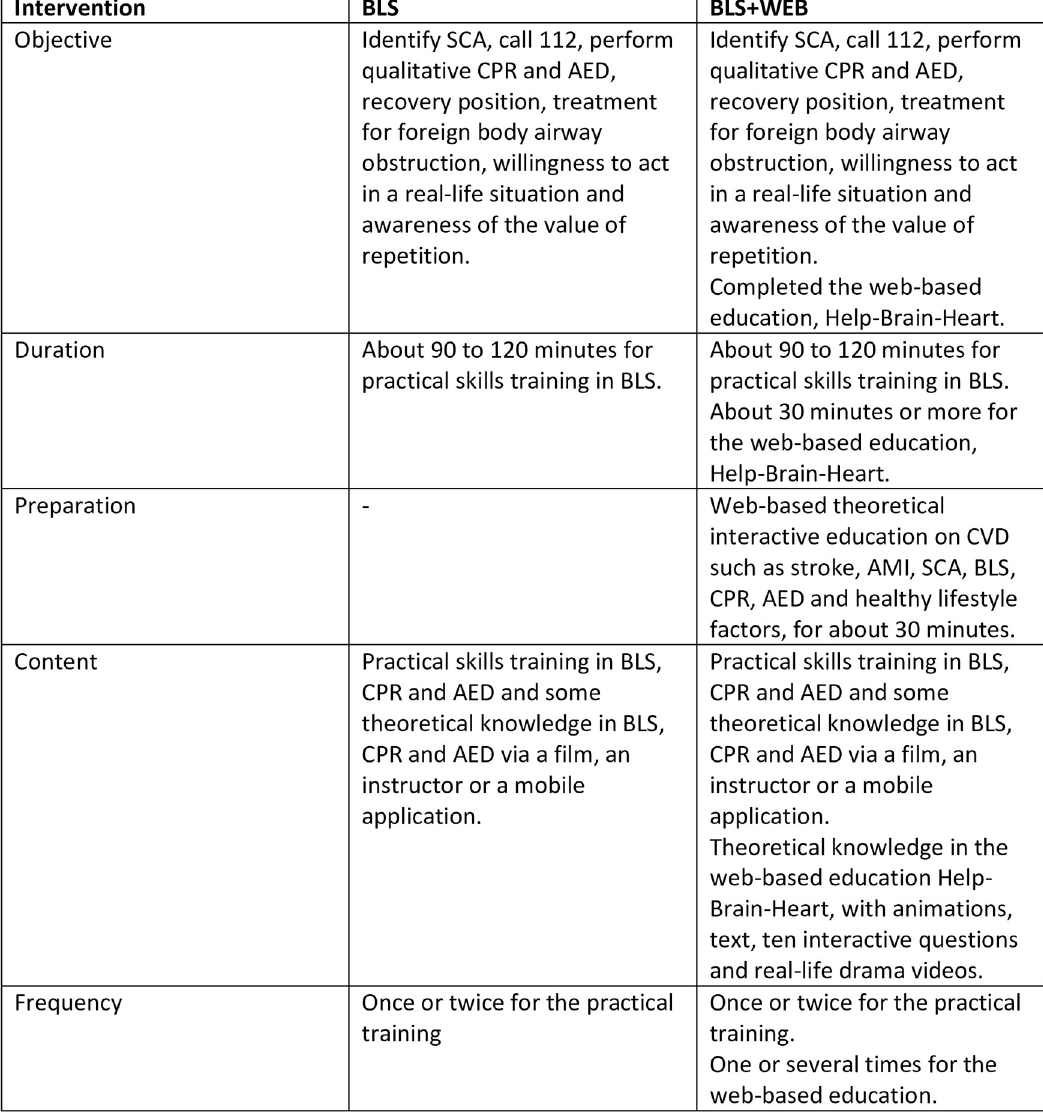
Fig 1. Description of the BLS intervention. Description of the educational intervention in the cluster randomised controlled trial, comparing learning outcome after training in basic life support (BLS) with training in basic life support including a preparatory web- based education on cardiovascular disease (BLS+WEB). Abbreviations: BLS, basic life support; BLS+WEB, basic life support plus a web-based education; SCA, sudden cardiac arrest; CPR, cardiopulmonary resuscitation; AED, automated external defibrillation; CVD, cardiovascular disease; AMI, acute myocardial